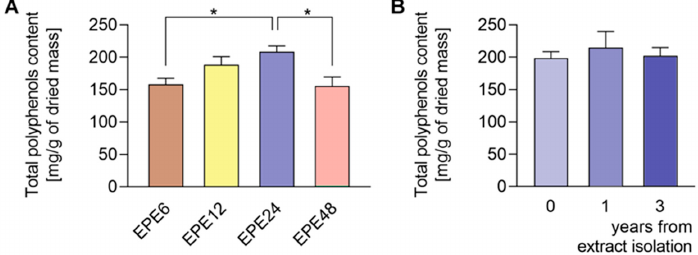
Figure 1. Determination of total polyphenols content (TPC) and its stability in evening primrose extracts (EPE) determined by the Folin–Ciocalteu method. ( A ) EPEs obtained in continuous Soxhlet extraction procedures performed for 6, 12, 24, and 48 h (EPE6, EPE12, EPE24, and EPE48, respectively). ( B ) Stability of EPE was determined by comparing the content immediately after extraction, as well as 1 and 3 years after extraction. TPC expressed in mg of GA per gram of dried extract. Data are means of three independent experiments ± SD. * p < 0.05 compared to control.